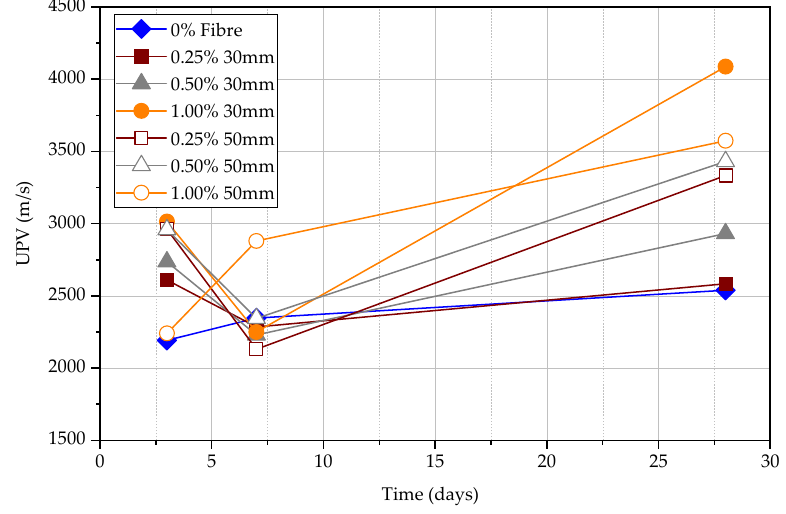
Figure 18. UPV indirect measurements with 100 mm path length. Table 7. Indirect UPV for different path lengths at 3, 7, and 28 days (m/s). Fibre Content and Length for 100 mm Path